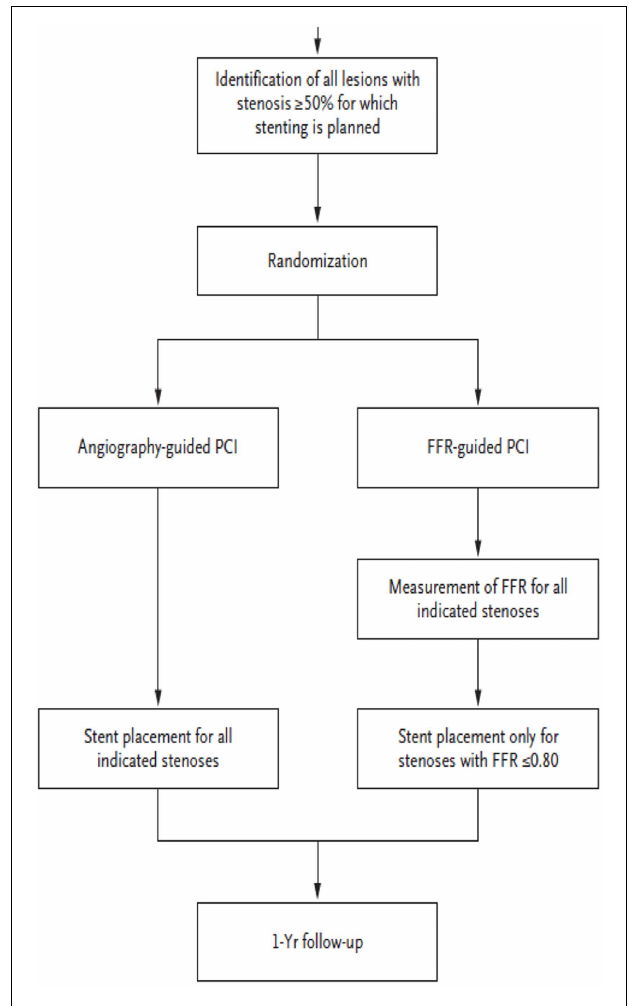
FIGURE 1 | Study design of the FAME trial